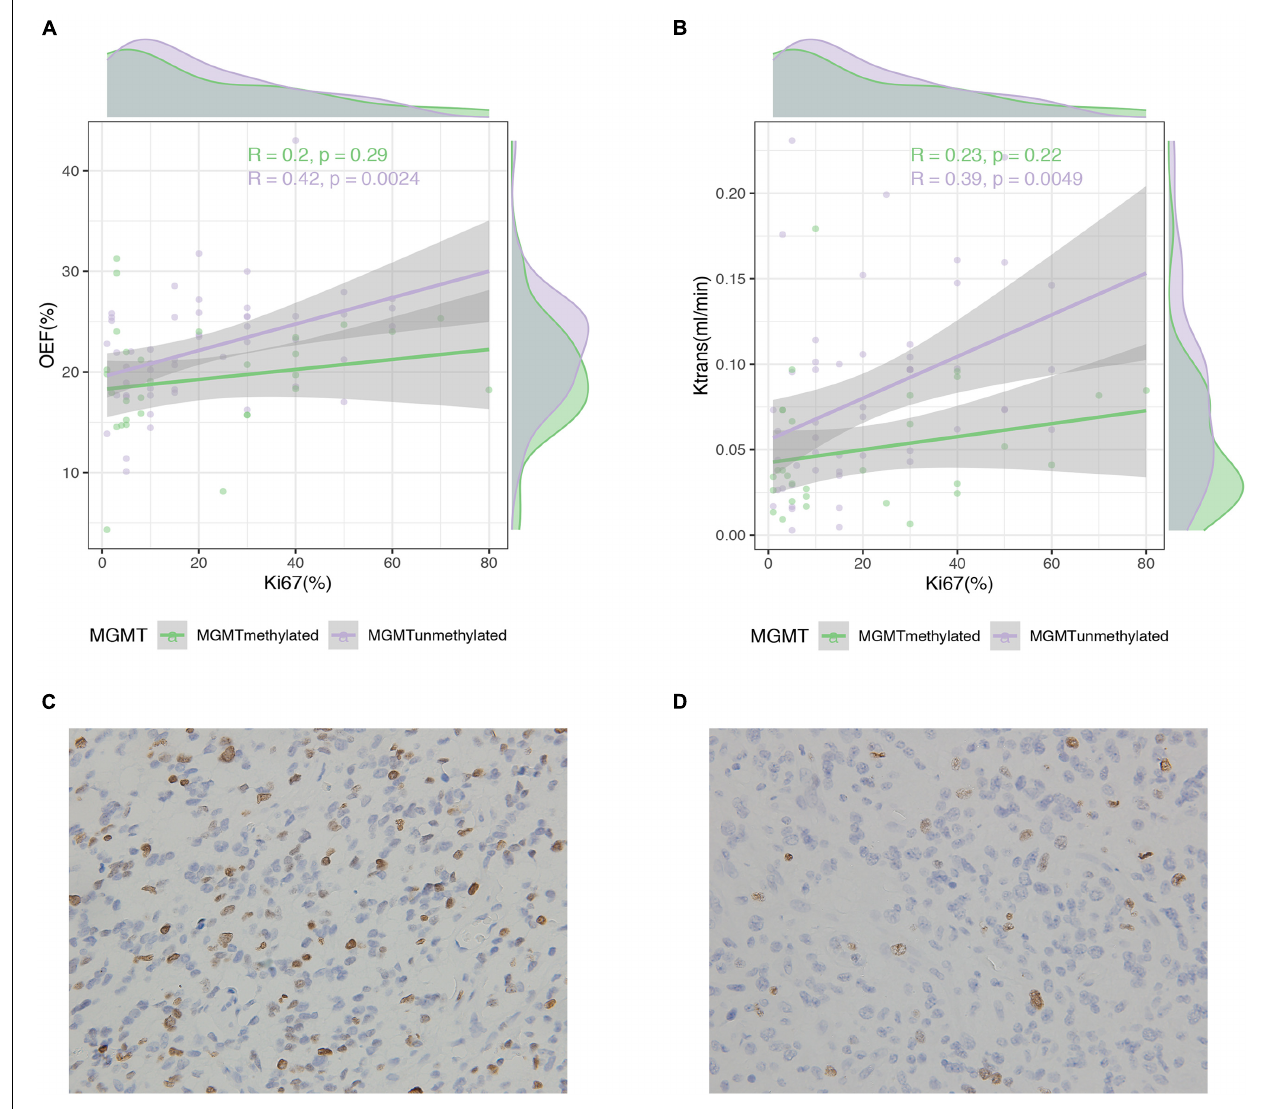
FIGURE 6 | Correlation between MRI measures and Ki67 expression in glioma patients. Scatterplot with linear regression line shows a weak to moderate association between MRI measures of OEF (A) and K trans (B) with Ki67 expression in MGMT promoter methylated and unmethylated gliomas followed by Ki-67 immunohistochemistry on the lower panel (C,D)